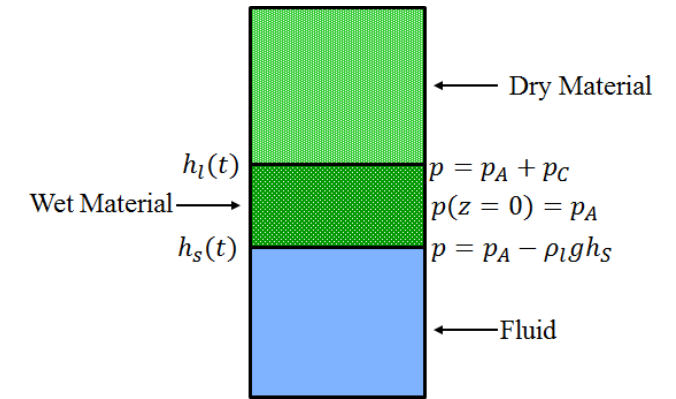
Figure 7. The dynamics of capillary rise after t >